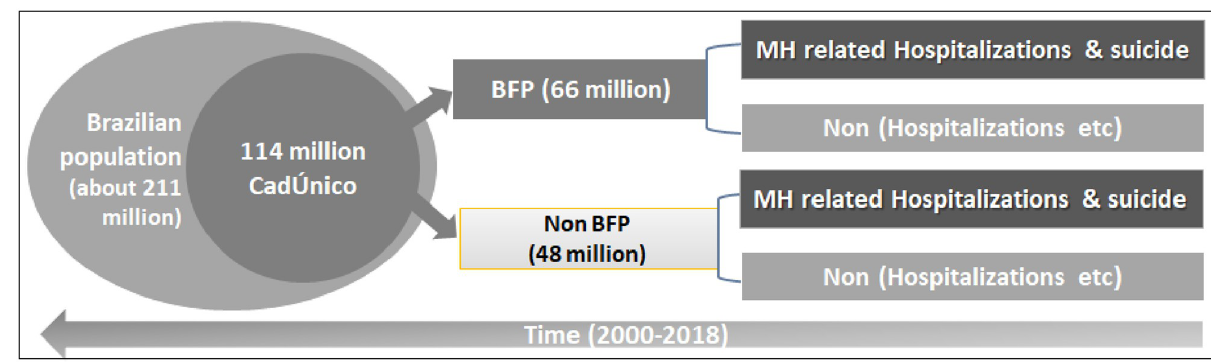
Fig 2. Flowchart of non-beneficiary (non-BFP) and beneficiary of the Bolsa Familia Program (BFP) to test the association between BFP and youth mental health-related hospitalizations and suicide.